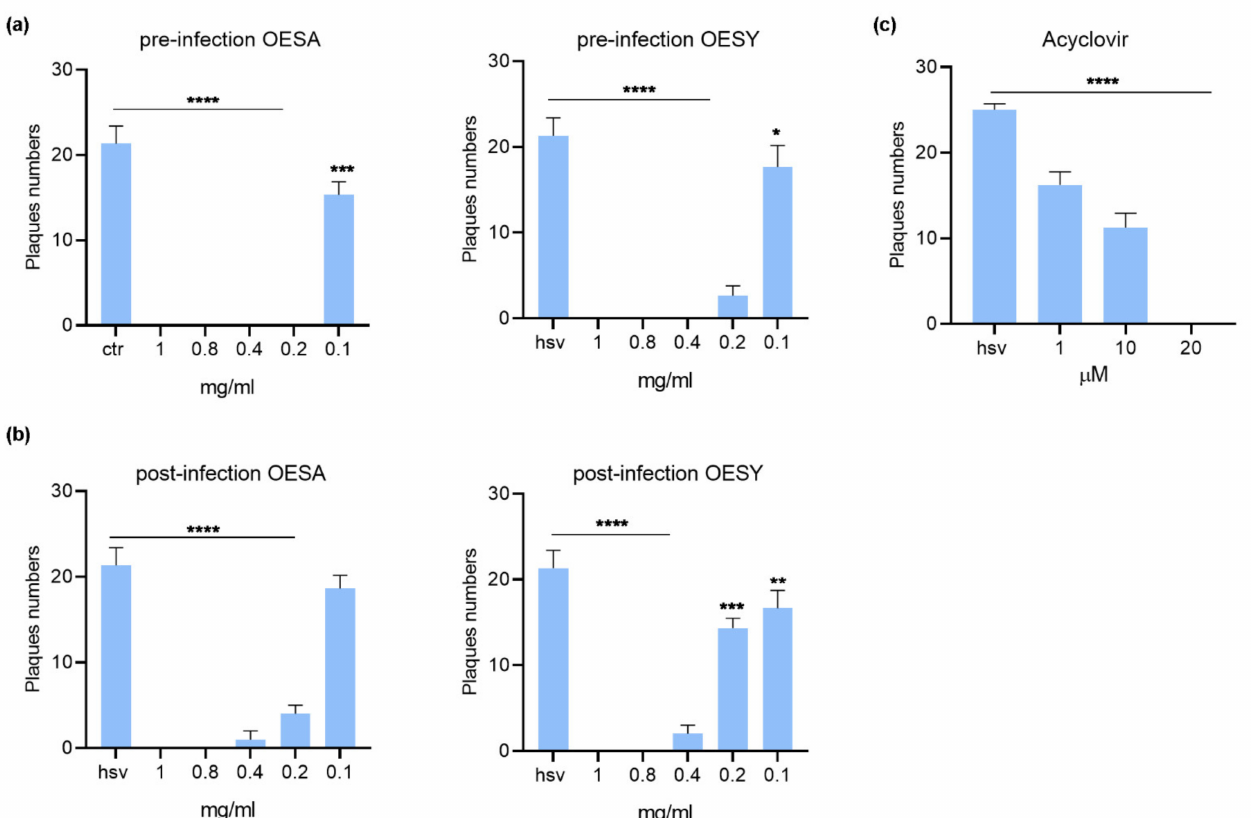
Figure 3. Plaque reduction assay from time-of-addition assay: ( a ) pre-infection condition, ( b ) post-infection condition treatments, and ( c ) Acyclovir control. Results are the mean ± SD of triplicate experiments, and asterisks indicate a significant p -value (* p < 0.05, ** p < 0.01, *** p < 0.001 and **** p < 0.0001). OESY, extract of O. europea var. sylvestris; OESA, extract of O. europea var.